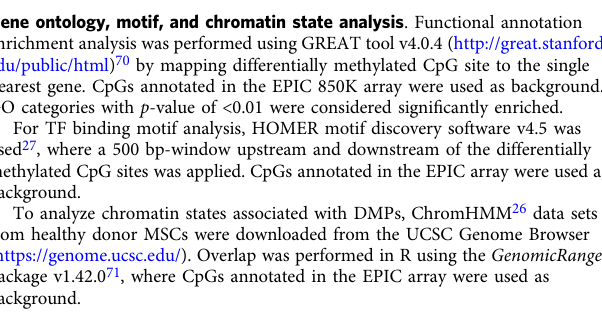
DNA methylation and gene expression pro fi ling using arrays . DNA samples were bisul fi te-converted using an EZ DNA methylation kit (Zymo Research, Orange, CA) and hybridized onto an In fi nium ® MethylationEPIC BeadChip array (Illumina, Inc.). The array platform allows the assessment of DNA methylation status at >850,000 CpG sites at single-nucleotide resolution and covers 99% of RefSeq genes and 95% of CpG islands with an average number of six probes per island. RNA samples were obtained from healthy donors ( n = 8), MGUS ( n = 10), SMM ( n = 10), and MM patients ( n = 24) at diagnosis and 100 ng of excellent quality RNA (RIN >9) was hybridized onto a GeneChip Human Gene 1.0 ST (Affymetrix). Quality control, data normalization, and detection of differentially methylated and variable CpGs . Methylation array data were processed in the statistical lan-